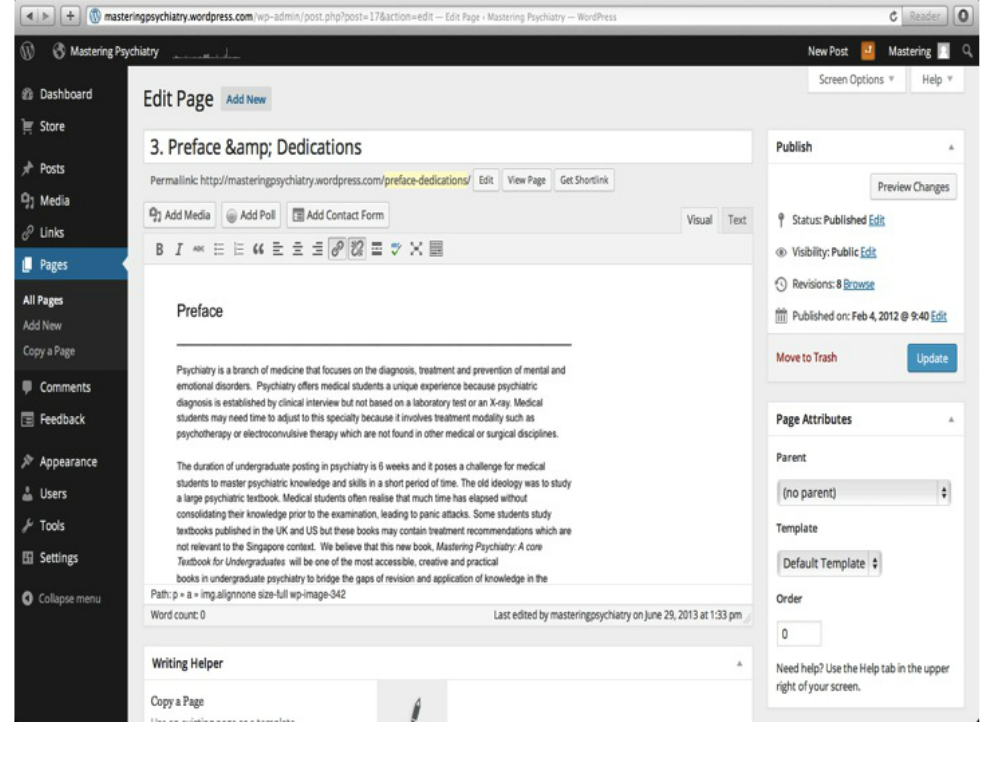
Figure 1. The graphic user interface of